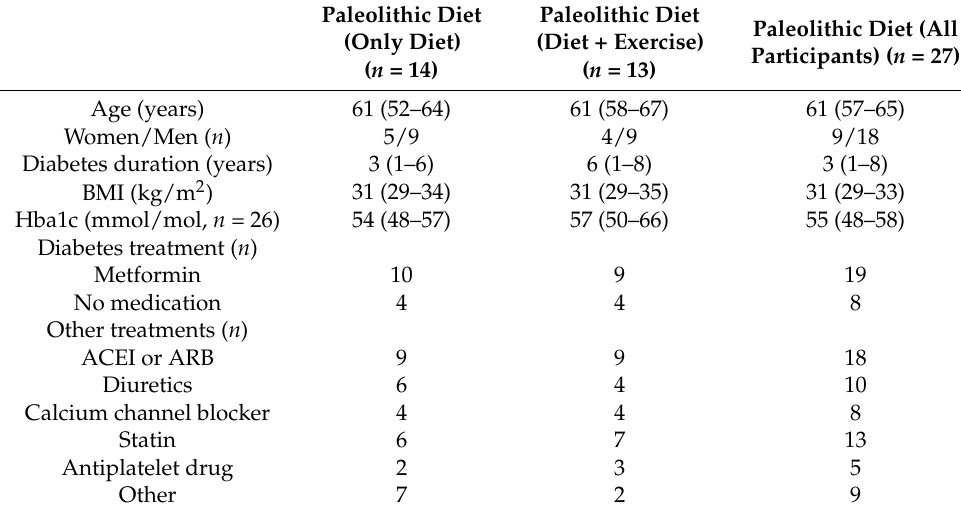
Table 1. Characteristics of